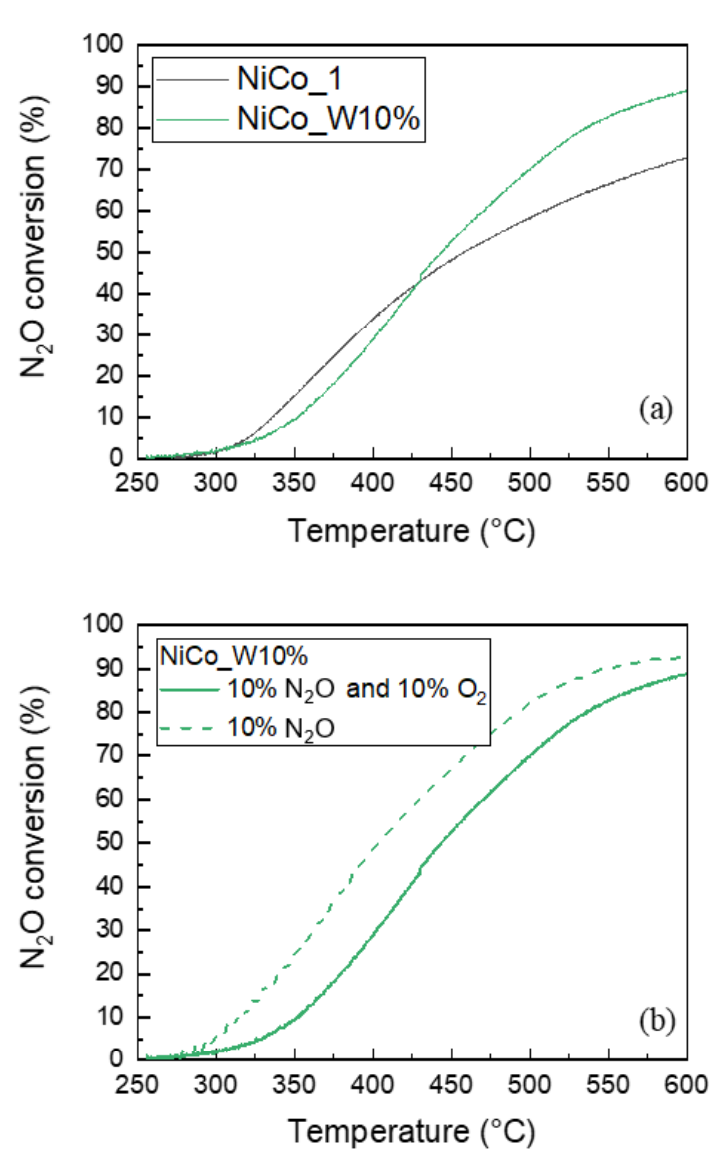
Figure 11. ( a ) Effect of alumina (10 wt%) addition (reagent mixture: 10 vol% N 2 O, 10 vol% O 2 in Ar) and ( b ) effect of O 2 presence in the feed gas. Operating conditions: GHSV = 15,000 h − 1 , 1 atm.